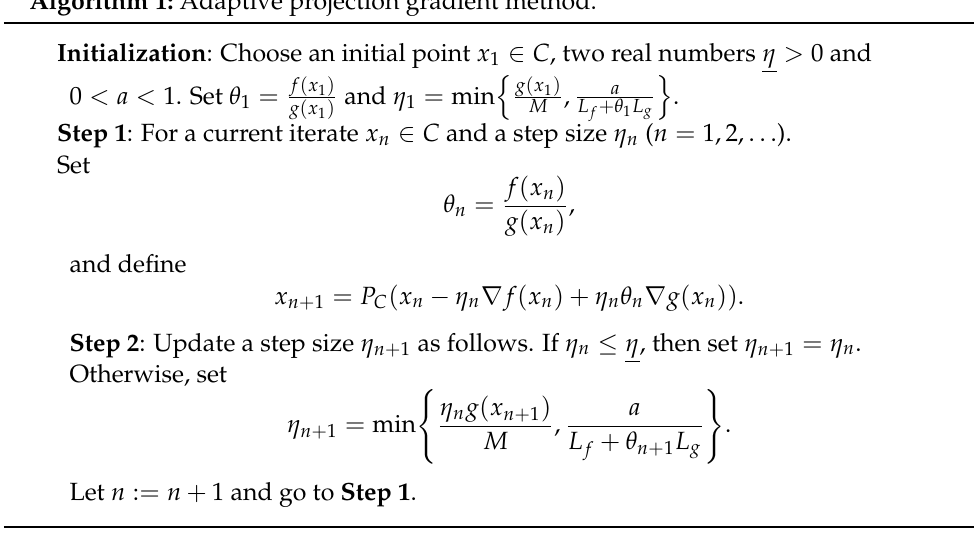
Algorithm 1: Adaptive projection gradient